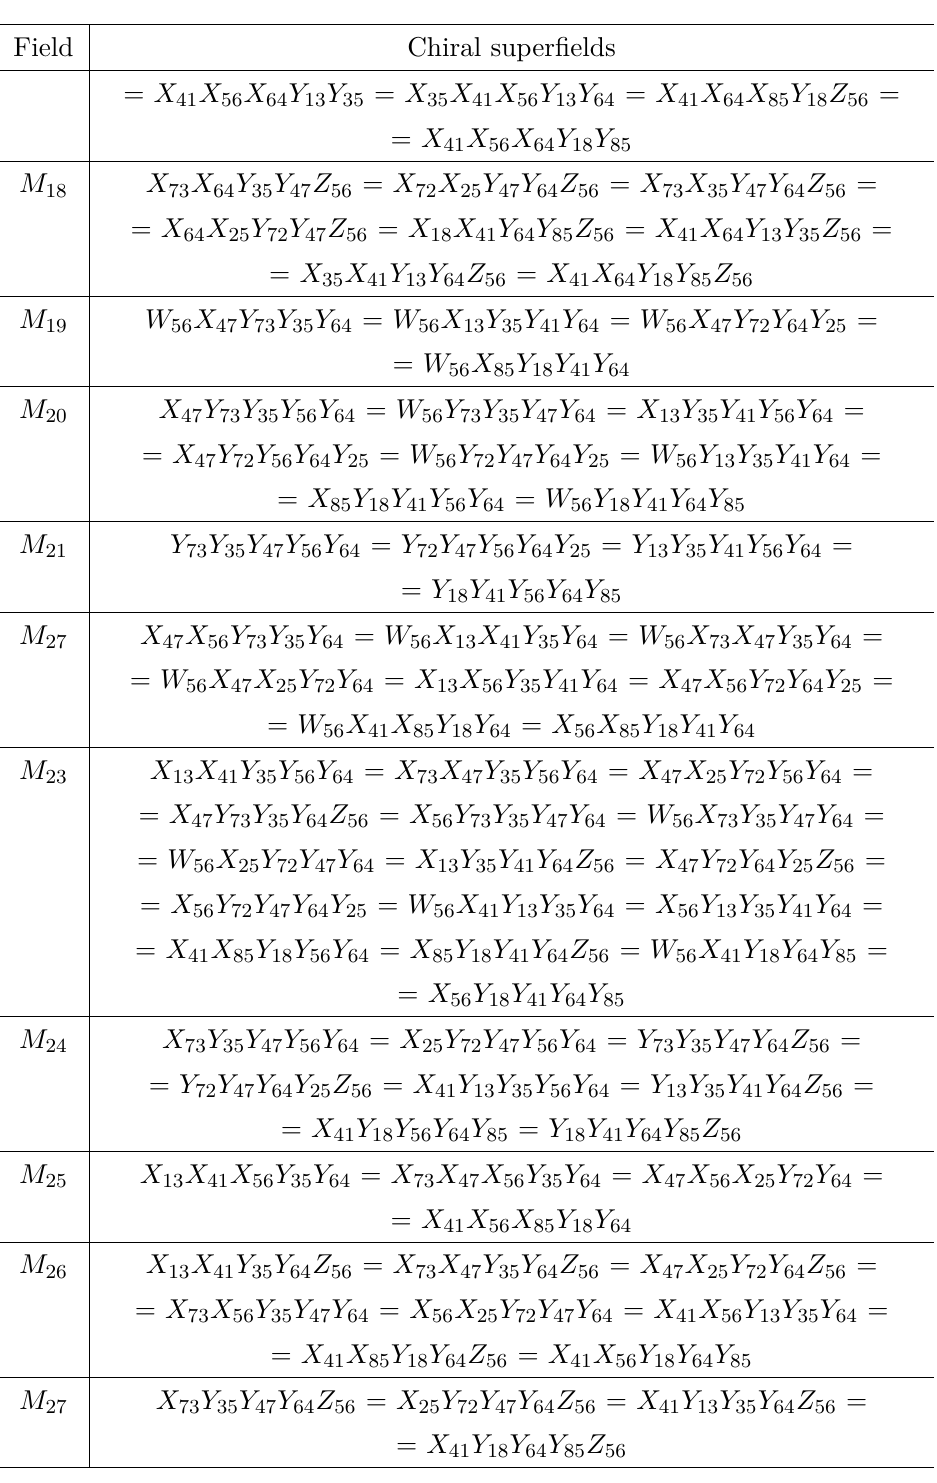
Table 8. Generators of Q 1 , 1 , 1 / Z 2 in Phase